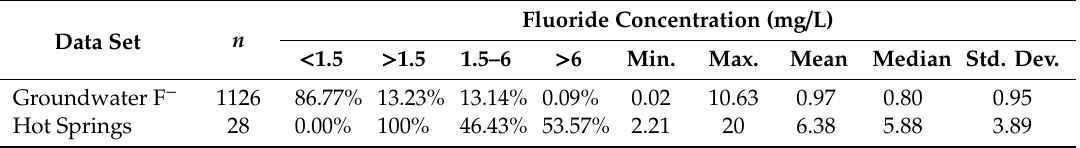
Table 2. Summary of groundwater fluoride data collated for use in this